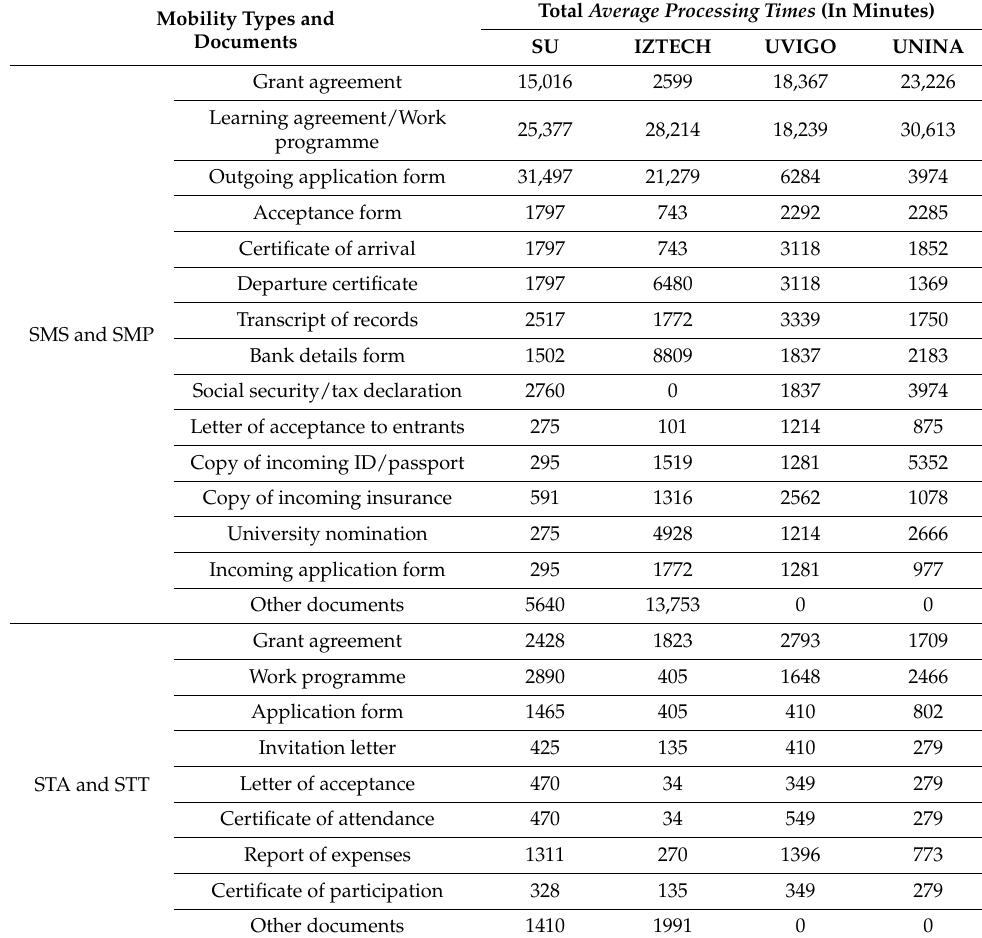
Table 3. Total Average Processing Times for the different